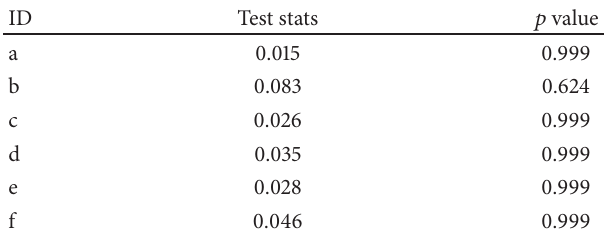
Table 4: The Kolmogorov-Smirnov goodness-of-fit test of the cumulative